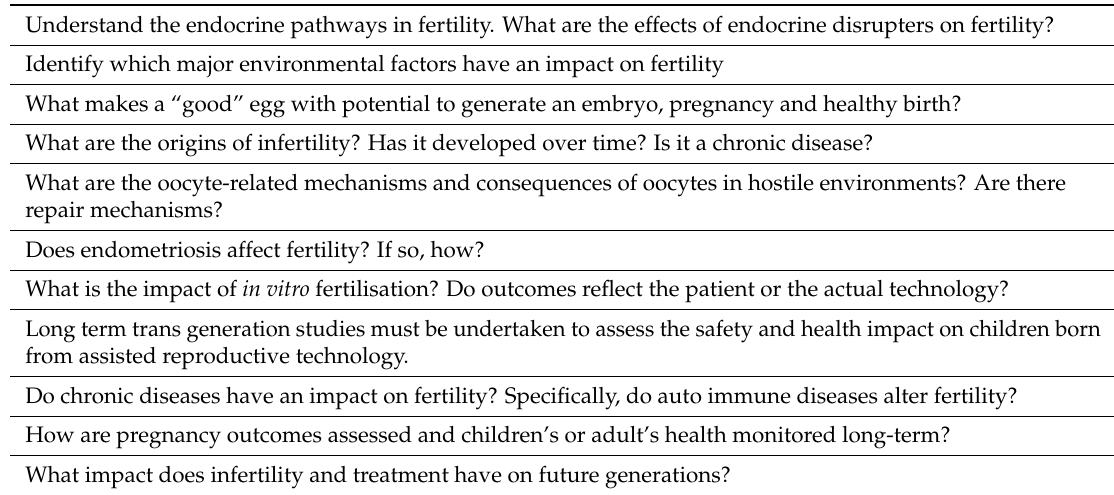
Table 3. Biological factors and preconception health and